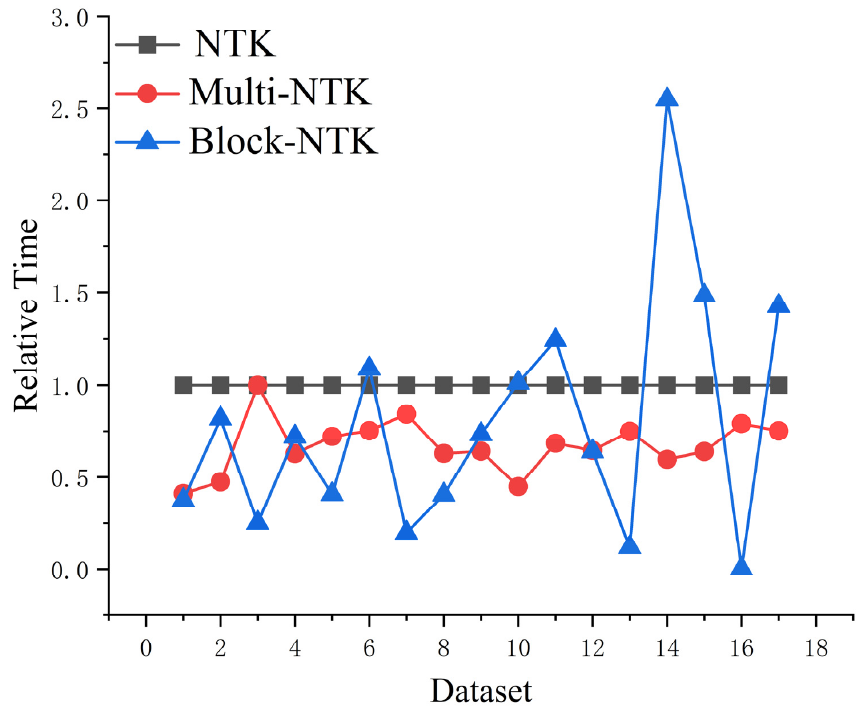
Figure 2. Model relative time comparison graph. Table 3. Selection of Boolean variables for selected datasets and model efficiency.